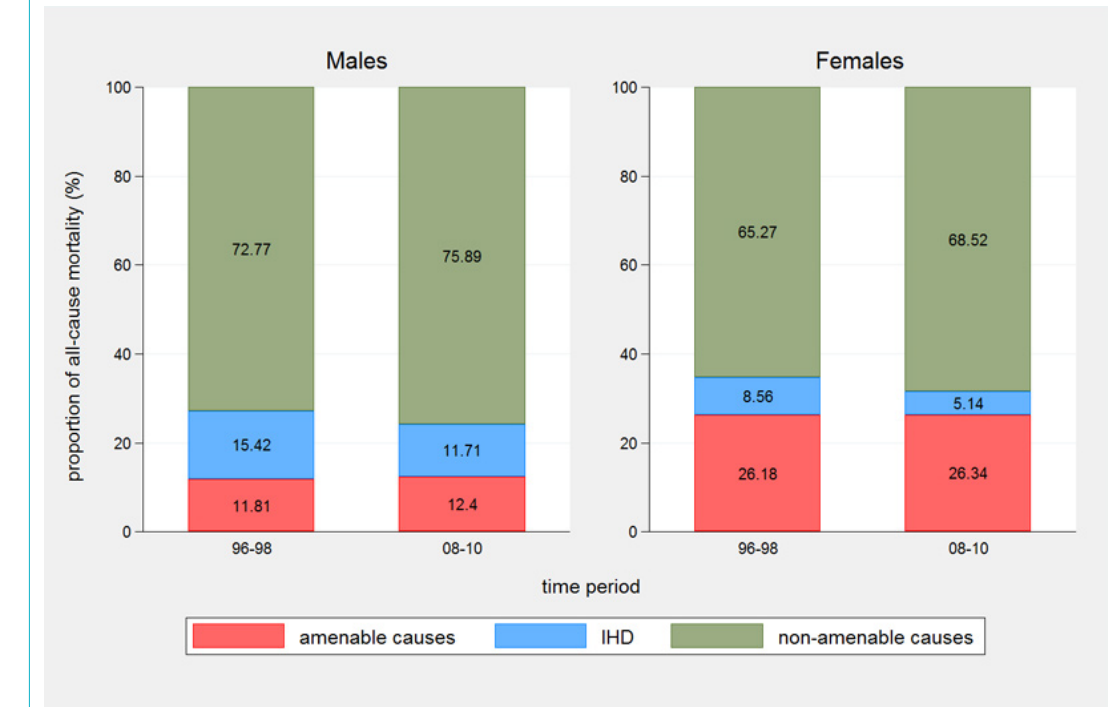
Figure 2: Proportion of all-cause mortality attributed to amenable causes, ischaemic heart diseases (IHD) and non-amenable causes based on 3-year age-standardised mortality rates (European standard [32]), age 0–74 years: by sex for the population of Switzerland, time period 1996–1998 and